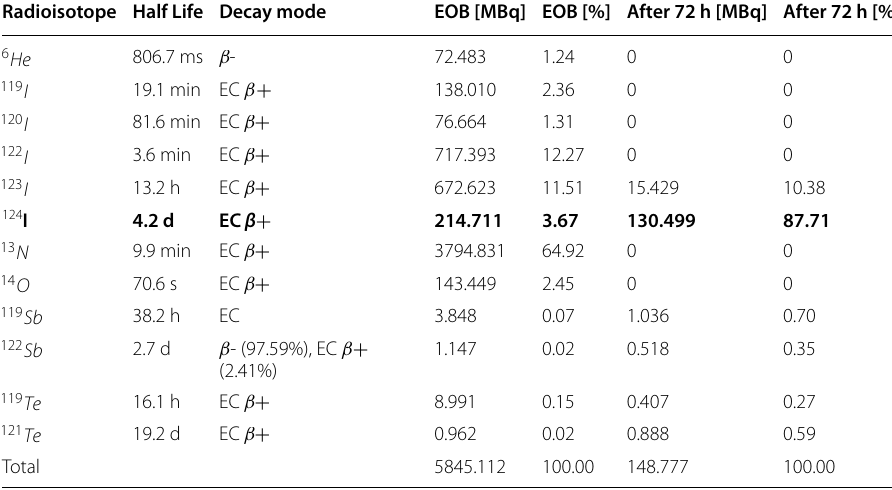
The production parameters: TeO 2 enriched in 124 Te, 18 MeV protons moderated to 14.8 MeV with 0.2 mm Havar, the proton current of 10 μA. The activity values at the end of bombardment (EOB) and the activity values after 72 hours since the end of bombardment are presented. 124 I is highlighted in bold